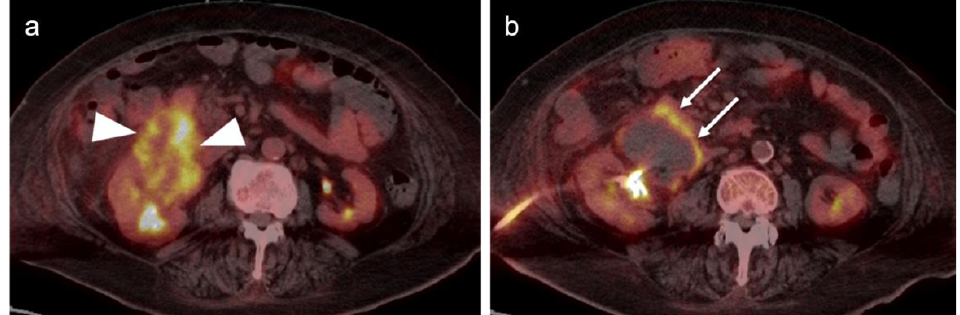
Figure 41. Upper tract urothelial carcinoma pre- and post chemotherapy on FDG PET-CT. ( a ) There is a large hypermetabolic renal pelvic mass prior to treatment (white arrowheads). ( b ) Following chemotherapy, there is a persistent mass that is centrally necrotic but shows a peripheral rim of metabolic activity suggesting persistent viable tumor (white arrows). There is a percutaneous nephrostomy tube.